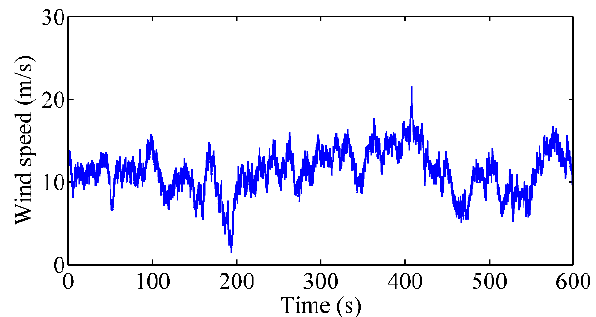
Figure 5. The time histories of V hub = 11.4 m/s.